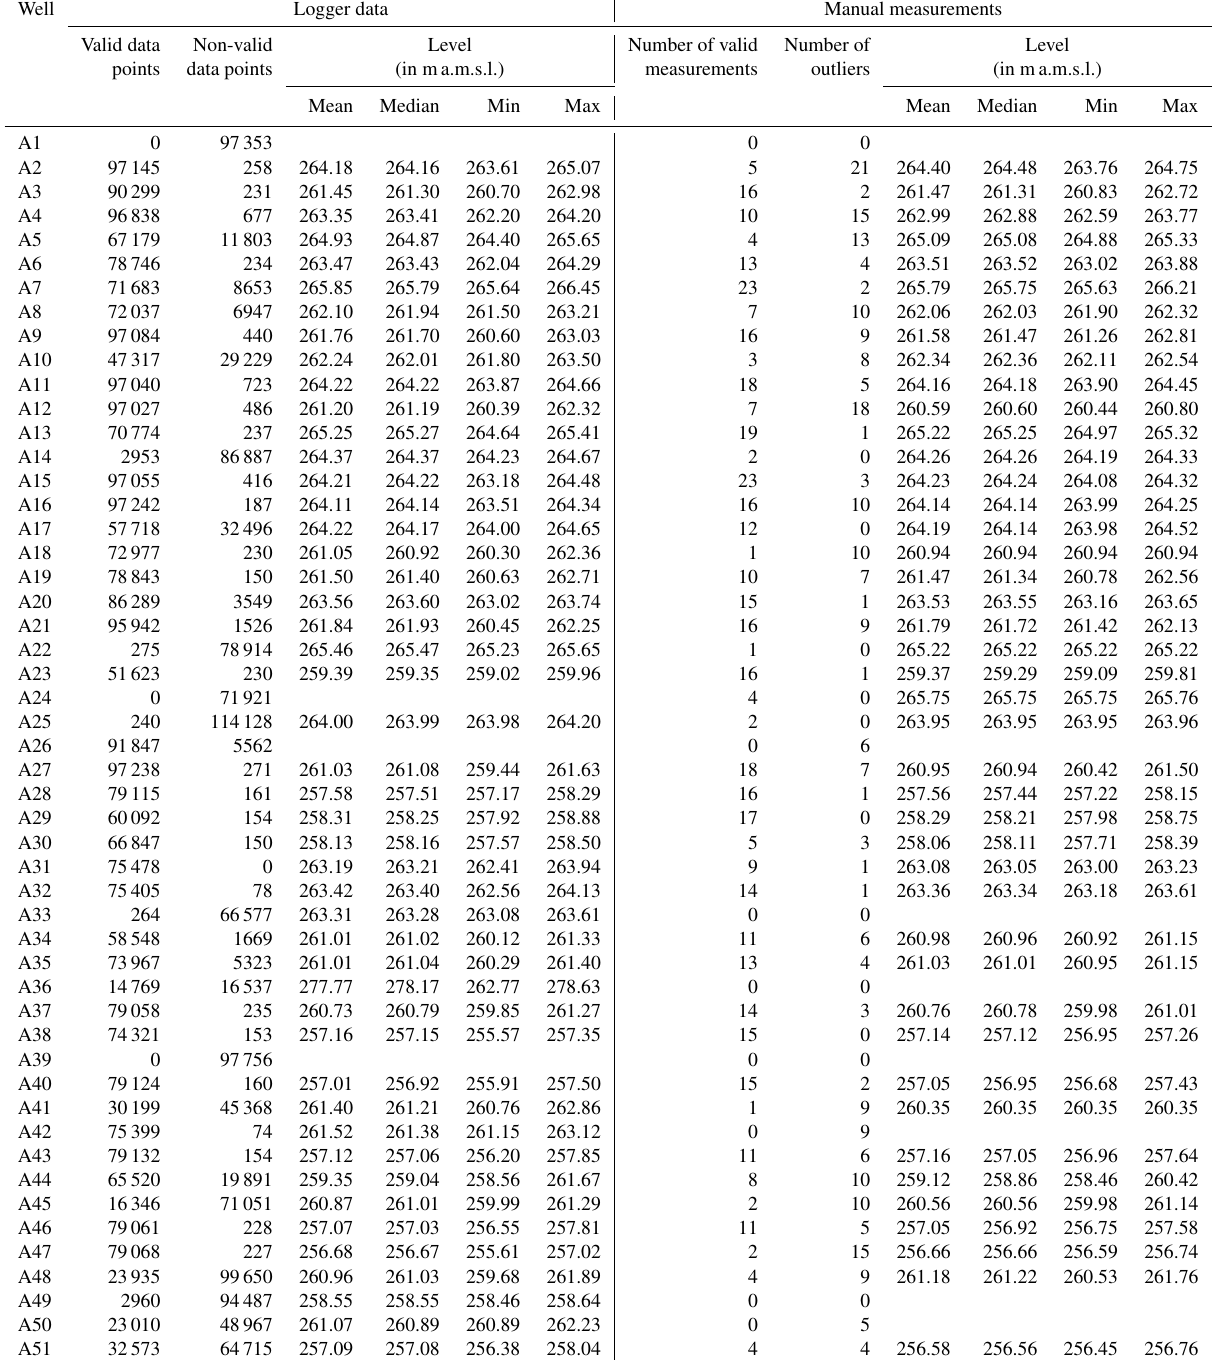
Table G1. Summary of the recorded water-level data per well and the manual measurements for each well. The summary statistics (mean, median, minimum, and maximum) were only calculated over the valid data points. Note that for some wells (e.g., A45 and A50) the number of valid data points is very small because the well was dry for most of the study period or the data were flagged as censored data. The number of outliers include the number of times that the well was dry as